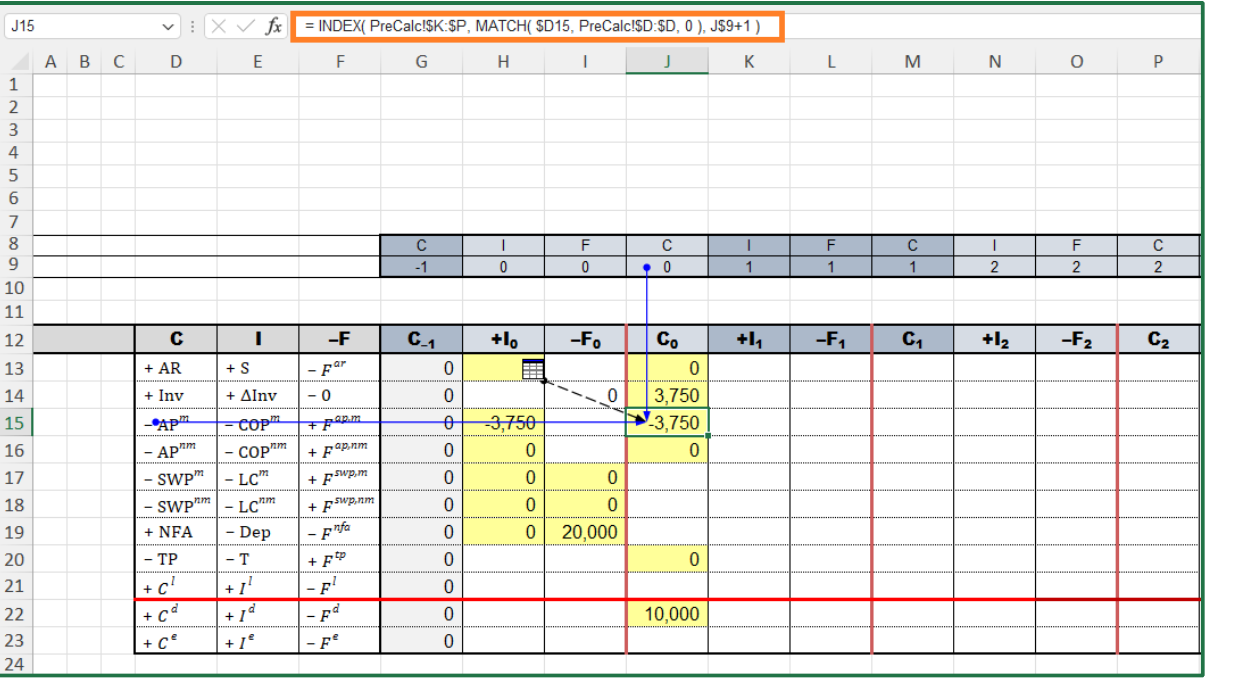
Figure 12. The 15 cells whose values are provided in “PreCalc” are in yellow. Cell J15 calculates the accounts payable for manufacturing activities at 𝑡 = 0 (“SplitScreenStrip” sheet)